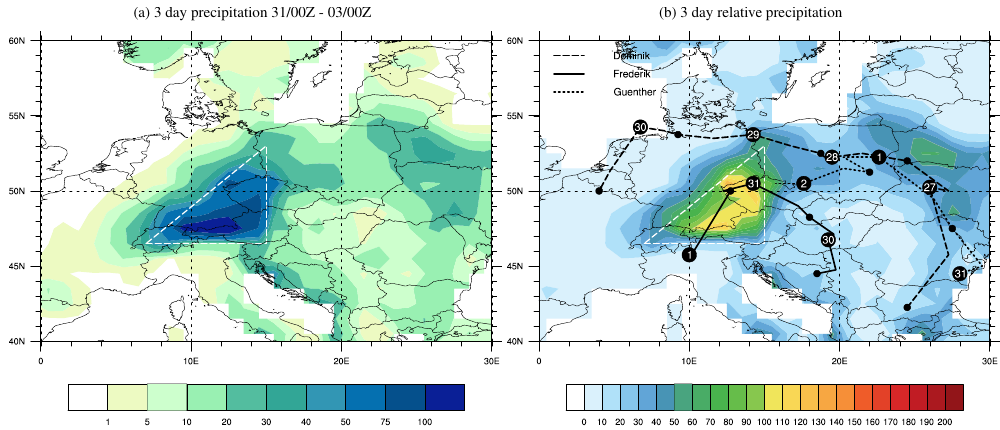
Figure 3. (a) : GPCC precipitation accumulated over the 3 day core period of the heavy precipitation event from 31 May 2013, 00:00UTC to 3 June 2013, 00:00UTC. (b) : fraction of total climatological May precipitation that fell in this 3day period (shaded every 10%, as Fig. 1b) and tracks of the three consecutive cyclones (long-dashed: Dominik, solid: Frederik, short-dashed: Günther; derived from ECMWF analysis data) with 00:00UTC labelled by day of May/June 2013 and small dots for 12:00UTC positions. The white triangle highlights the core region affected by heavy precipitation.